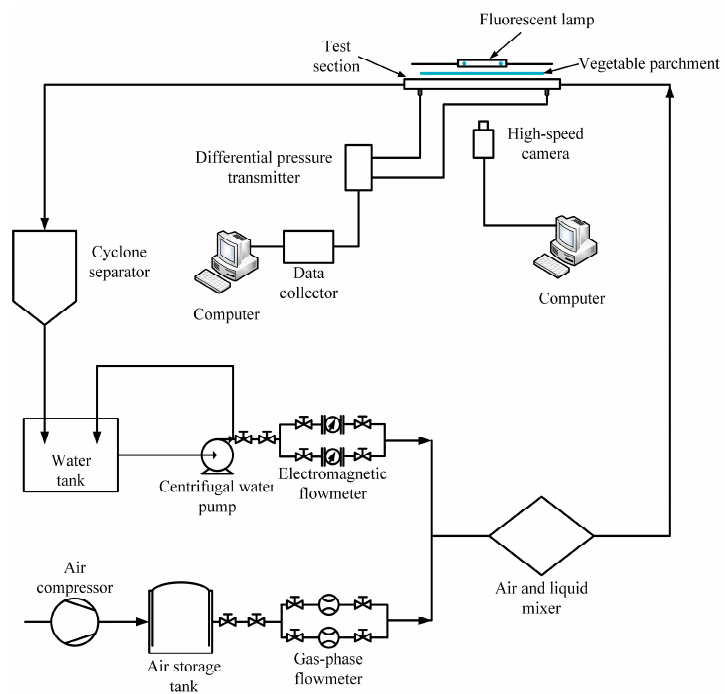
Figure 1. Experimental system.